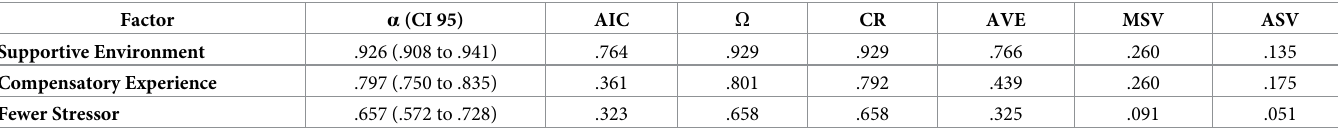
Table 3. Convergent and divergent validity, internal consistency, and constructs reliability of BPFI. Factor α (CI 95) AIC O CR AVE MSV